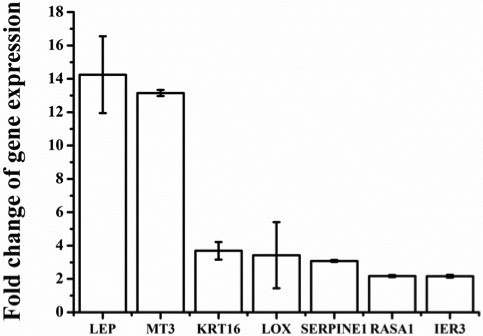
Real-time PCR (RTqPCR) validation of differentially expressed genes. RTqPCR was implemented on the same mRNA samples used for microarray as described in Methods. Results are mean ± SEM of n = 3.